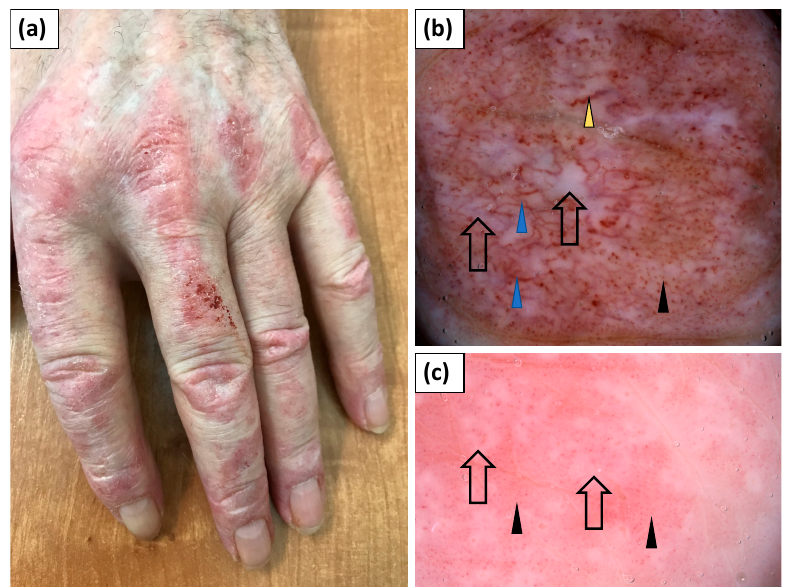
Figure 3. ( a ) Clinical presentation of erythematous papules and plaques over the metacarpophalangeal and interphalangeal joints (Gottron’s papules). ( b ) Videodermoscopy of Gottron’s papules showed irregularly distributed dotted (black arrowhead), linear vessels with branches (blue arrowhead), and linear curved vessels (yellow arrowhead) surrounding white structureless areas (black arrow). ( c ) Videodermoscopy of Gottron’s papules showing predominantly dotted vessels (black arrowhead) surrounding irregular pink structureless areas (black arrow).